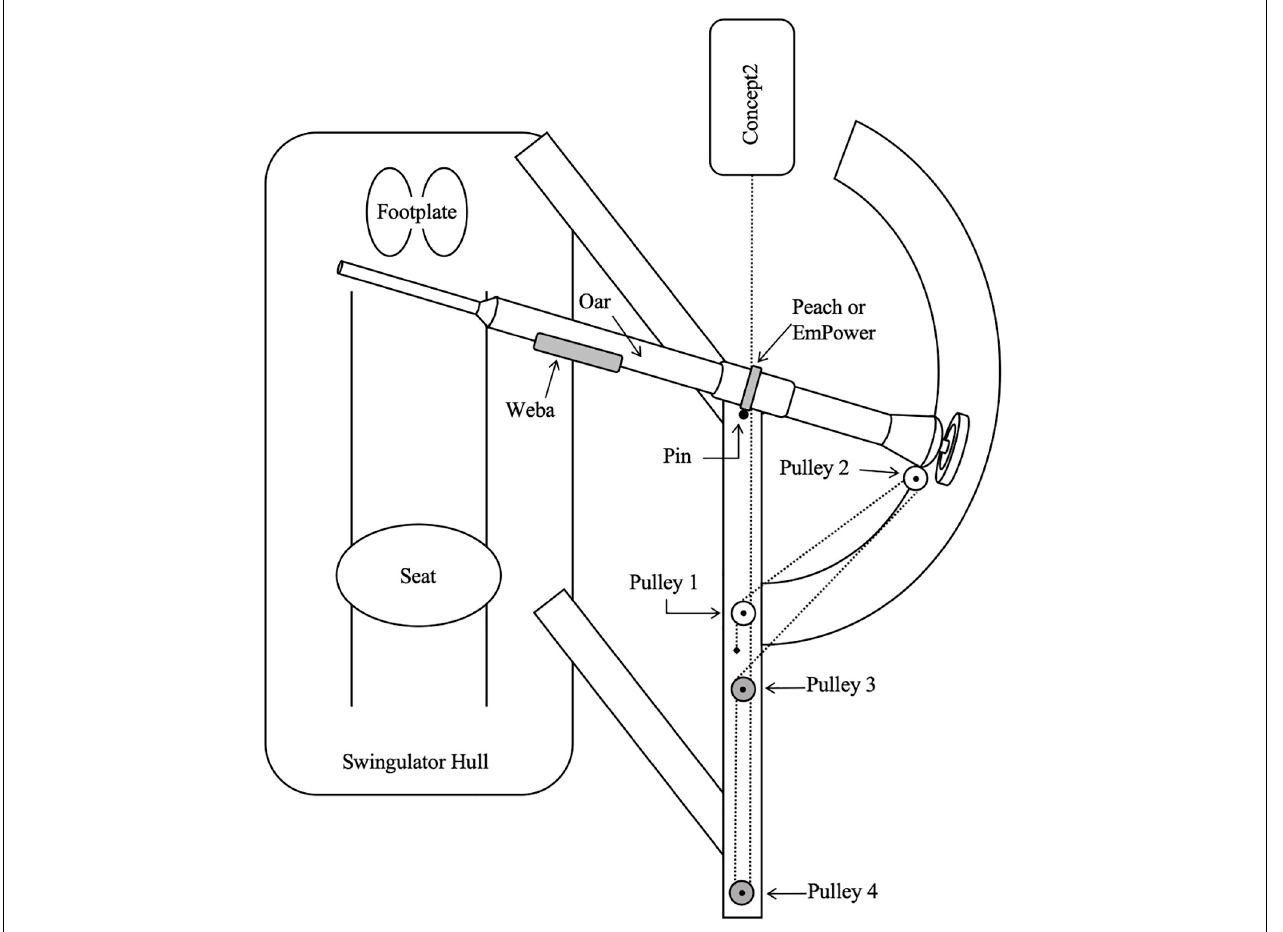
FIGURE 1 | Birds-eye view diagram (not drawn to scale) of Swingulator-system illustrating location of devices. Pin, point of oar rotation. Pulley 2 is attached to the oar, Pulleys 3 and 4 are located on the underside of the Swingulator framing. Dashed line represents the Concept2 chain and Swingulator cord which passes under the framing after Pulley 2. The black diamond near Pulley 1 indicates the anchor point of the Swingulator cord.